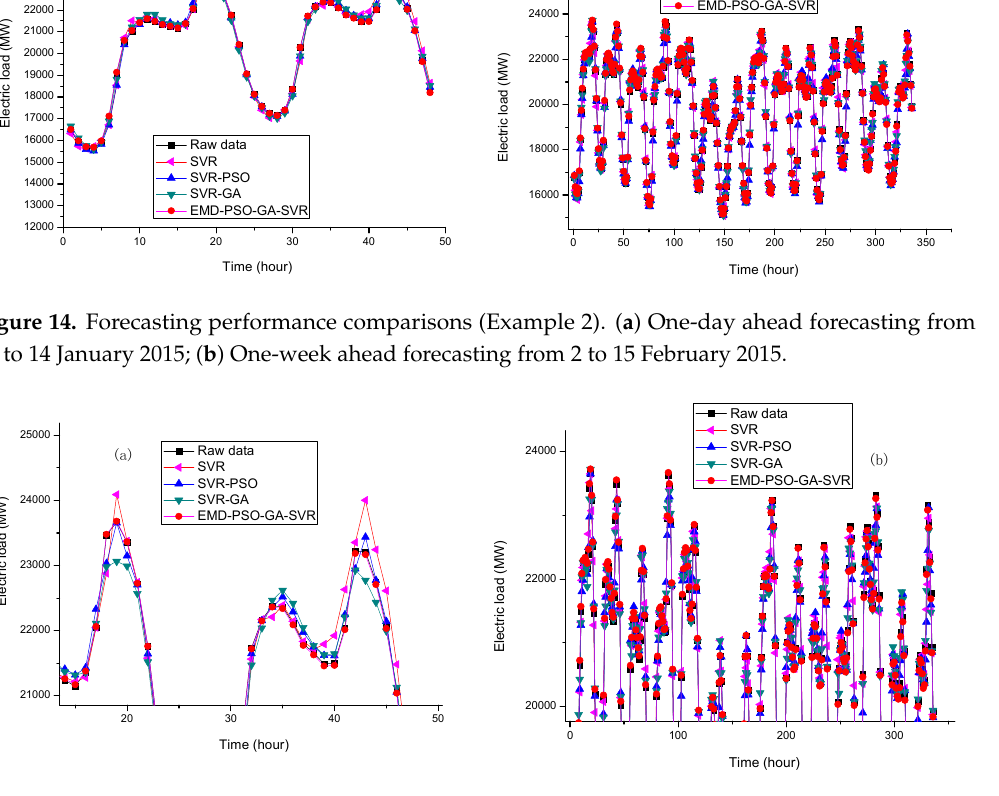
Figure 15. The local enlargement (peak) comparisons (Example 2). ( a ) One-day ahead forecasting from 13 to 14 January 2015; ( b ) One-week ahead forecasting from 2 to15 February 2015.